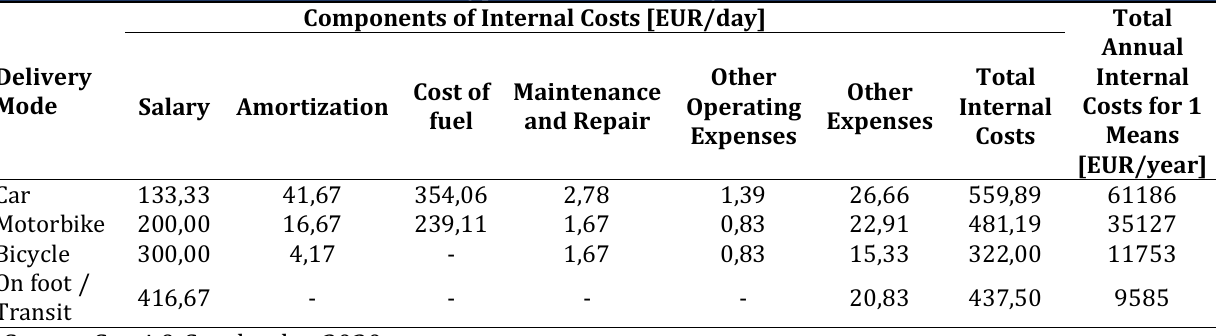
Table 2: Direct internal costs for various types of urban delivery modes